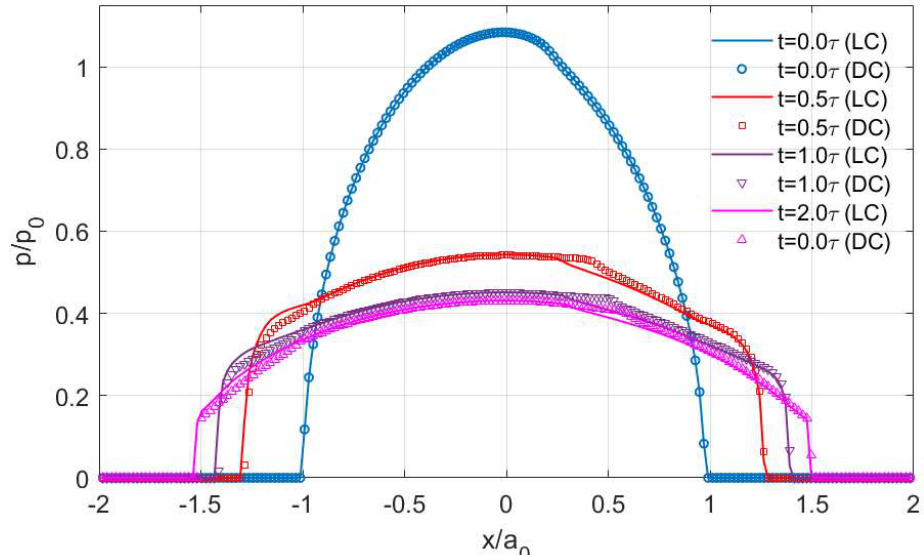
Figure 18. Changes in normal pressure distribution p along the x axis with time in the LC (solid line) and DC (scatter plot) cases.